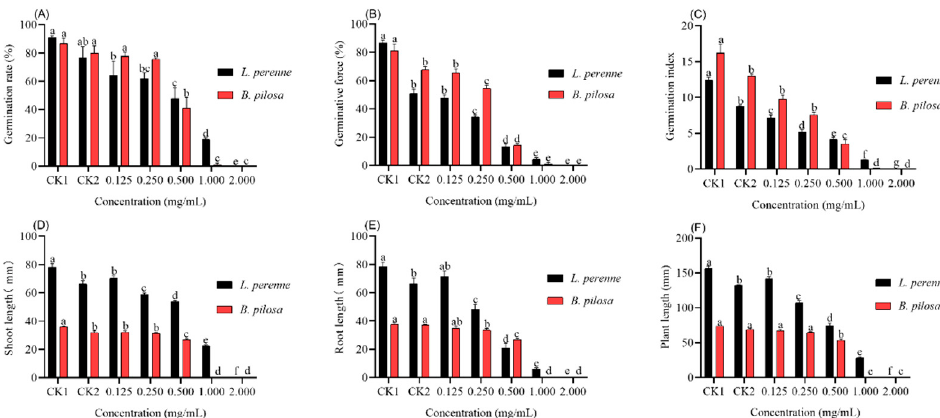
Figure 1. Effect of different concentration of L. pungens essential oil on seed germination and seedling growth (CK1, blank control; CK2, negative control; ( A ), Germination rate; ( B ), Germination force; ( C ), Germination index; ( D ), Shoot length; ( E ), Root length; ( F ), Plant length). Note: different lowercase letters (a–g) represent statistical differences (Tukey’s test p < 0.05).